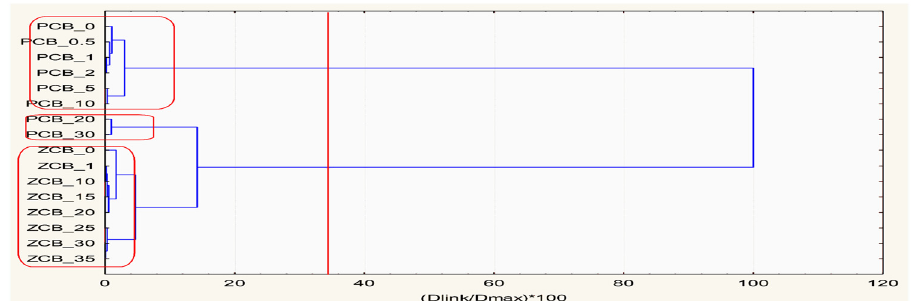
Figure 2: Hierarchical dendrogram for clustering of 16 glass